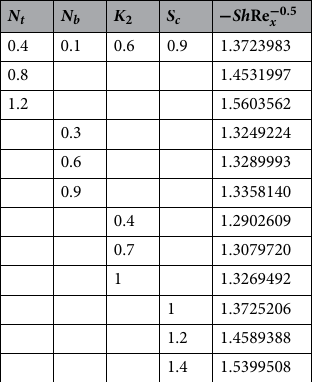
Table 4. Computational values of Sh Re − 0.5 x for several values of N t , N b , K 2 , S c when β = ω = Ha = (cid:31) = δ v = 0.5, Pr = 2, K 1 = 0.6 D = H = 0.1, δ T = 0.3, γ = 0.7, K = 1 = E , n =